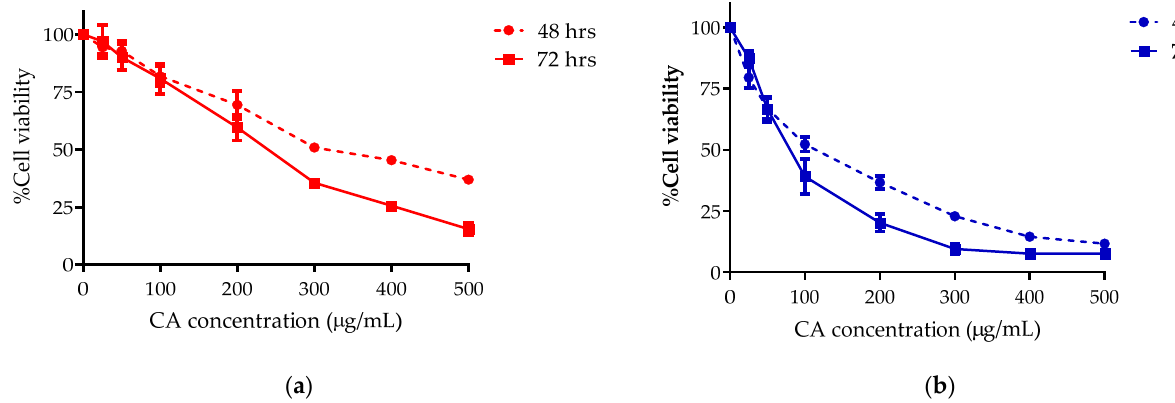
Figure 1. The cell viability of ( a ) KKU-100 and ( b ) KKU-213 after CA treatment for 48 and 72 h; data represents the mean ± standard deviation of three independent experiments.